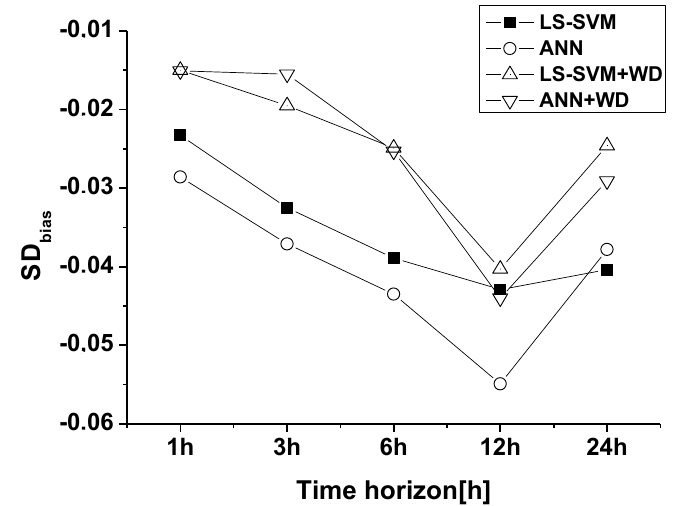
Figure 8. SD for input vector Type II by LS-SVM and ANN without and with WD. bias